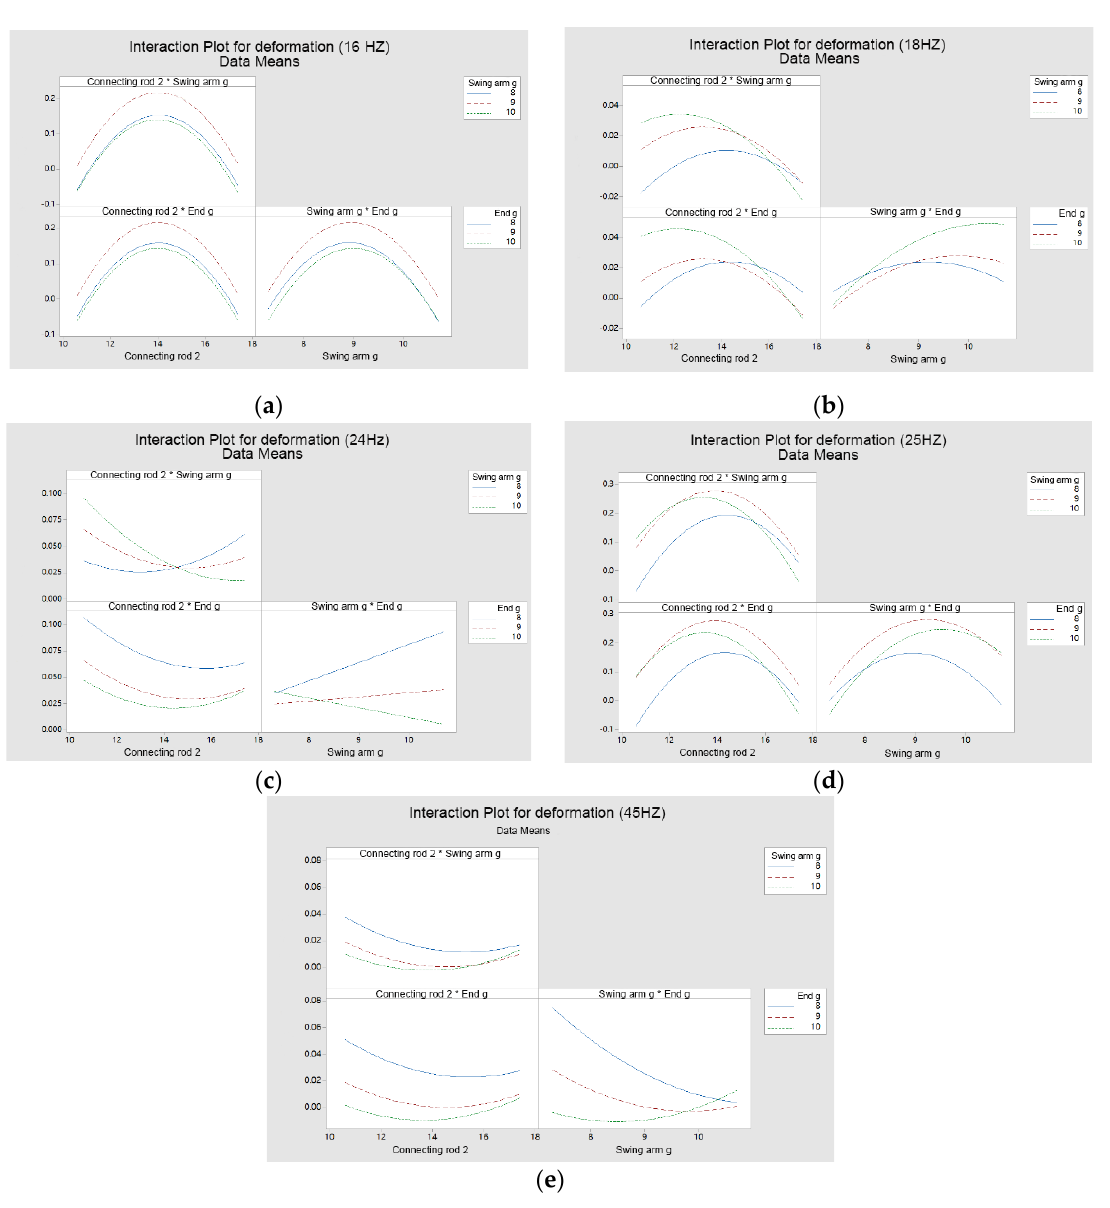
Figure 16. Interaction diagrams for the amplitude displacement at the end of the welding robot: ( a ) 16 Hz; ( b ) 18 Hz; ( c ) 24 Hz; ( d ) 25 Hz; ( e ) 45 Hz. (The sign * in the figure means the interaction of two